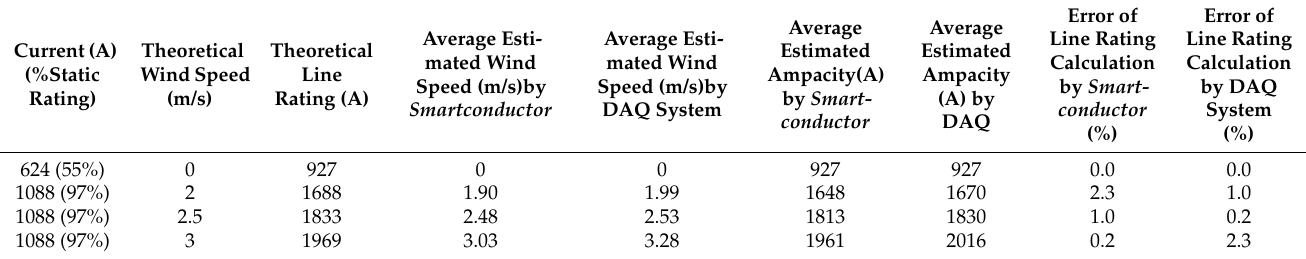
Table 5. Results of estimated wind speed and ampacity predicted by the proposed approach.